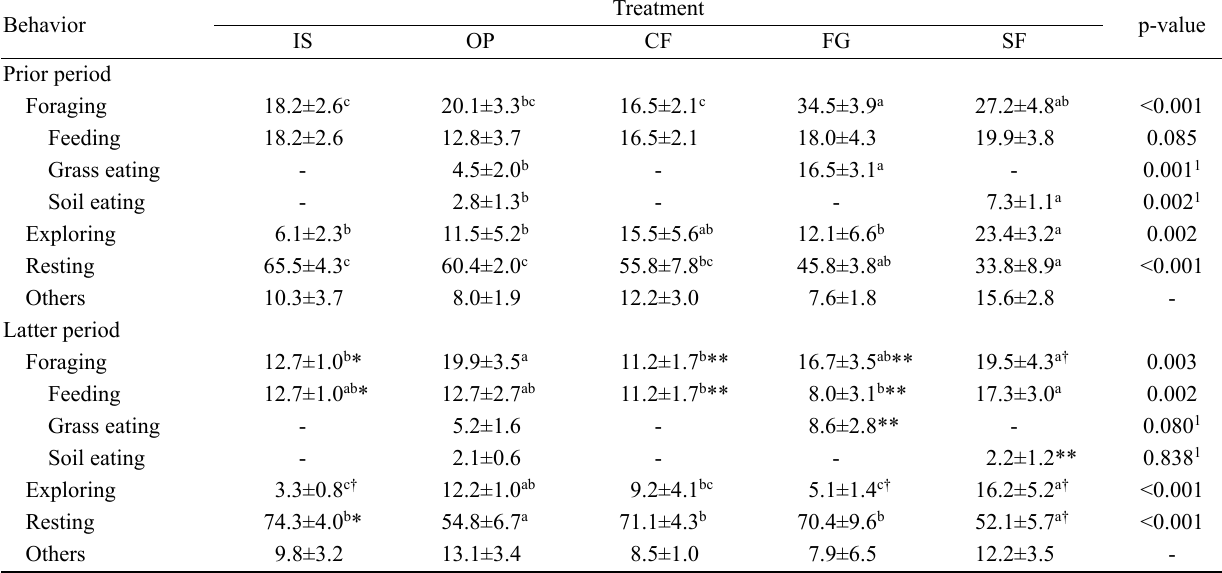
Table 3. Time budgets (% in the observation period) of behavioral states in pigs in the five treatments